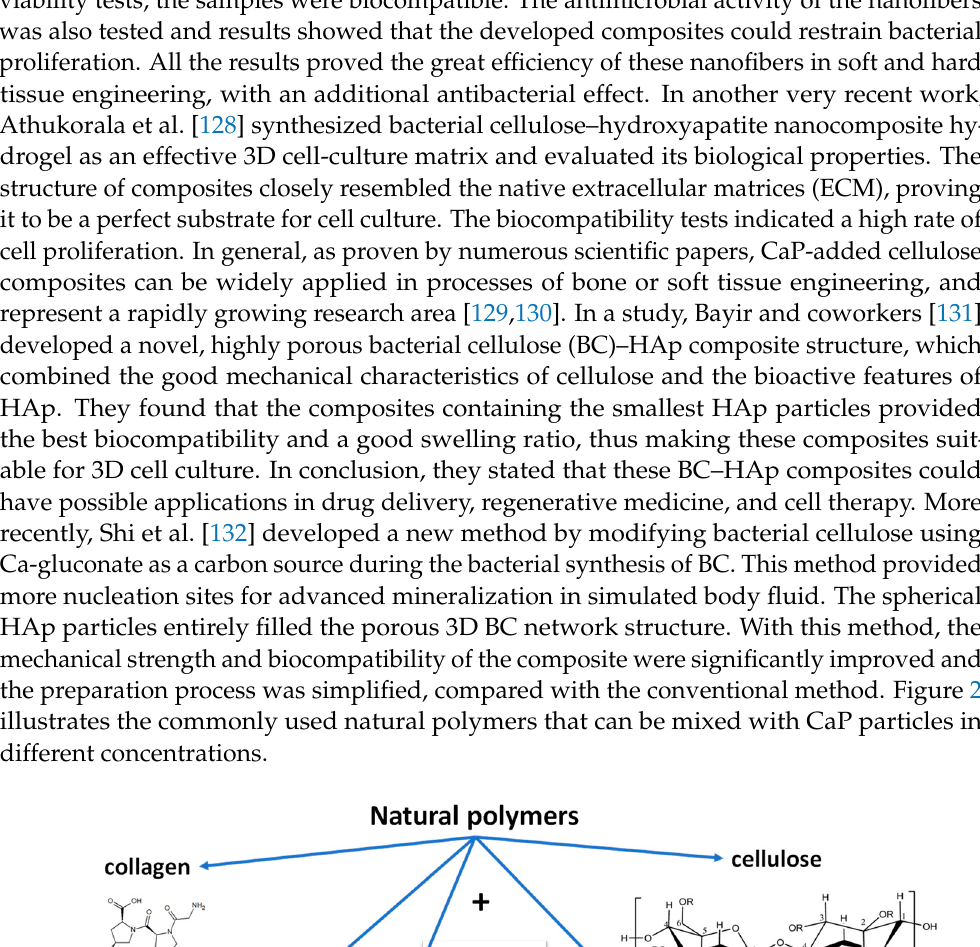
Figure 3. Graphical illustration of the most frequently used synthetic polymers that can be used as CaP-containing composites, their possible application forms, and preparation methods. In Table 1, we summarize the reported properties, forms as well as common application areas of CaP-loaded natural polymer composites. Table 1. CaP containing natural polymer composites in bone tissue engineering. Polymer Matrices